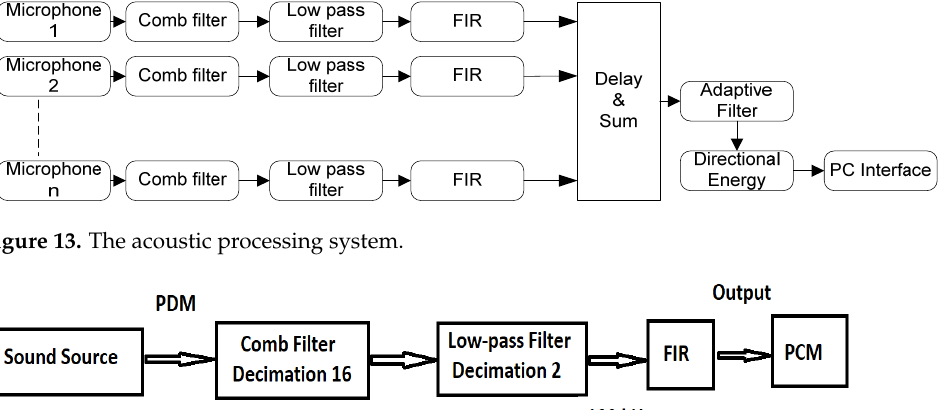
Figure 13. The acoustic processing system. Figure 14. Convert from PDM to PCM. Figure 14. Convert from PDM to PCM. Figure 14. Convert from PDM to